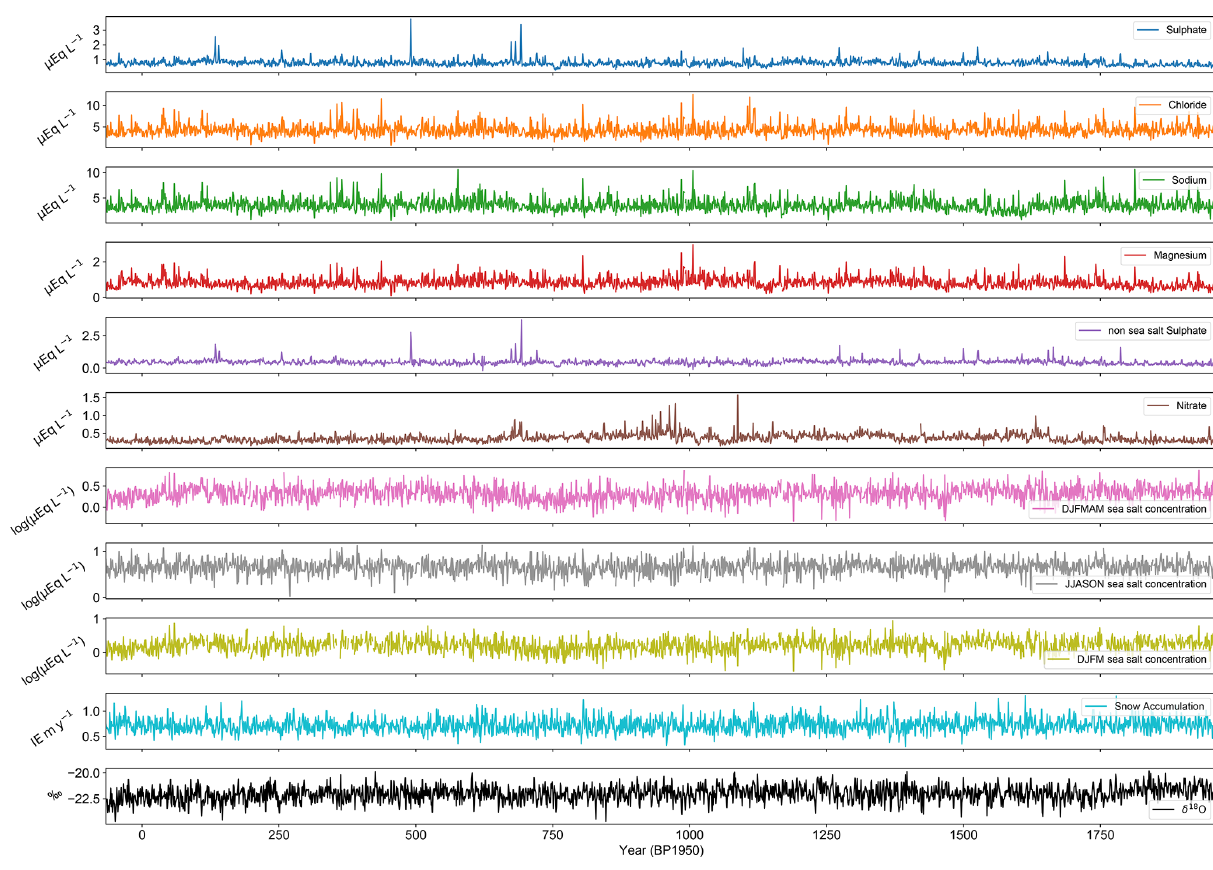
Figure 6. Time series for all annual records include trace chemistry analytes, stable water isotopes, accumulation and derived seasonal sea salts.